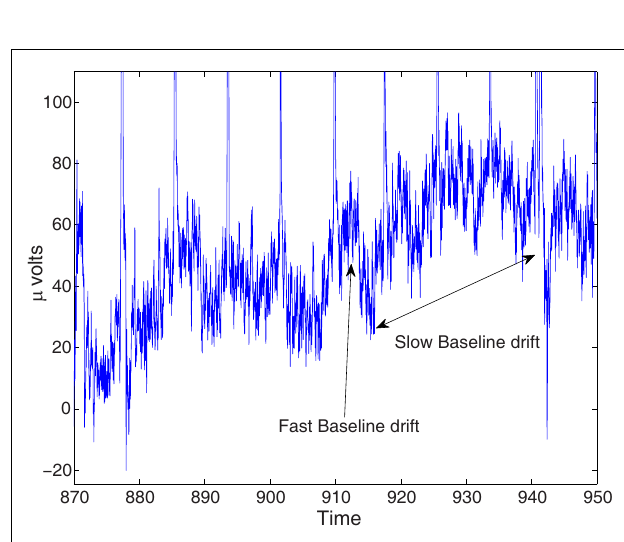
FIGURE 9 | (Data Set 1 – artificial). Example of fast and slow baseline drifts that are observable in unfiltered BCI competition IV data.The figure depicts the time course of the amplitude of the EEG in one